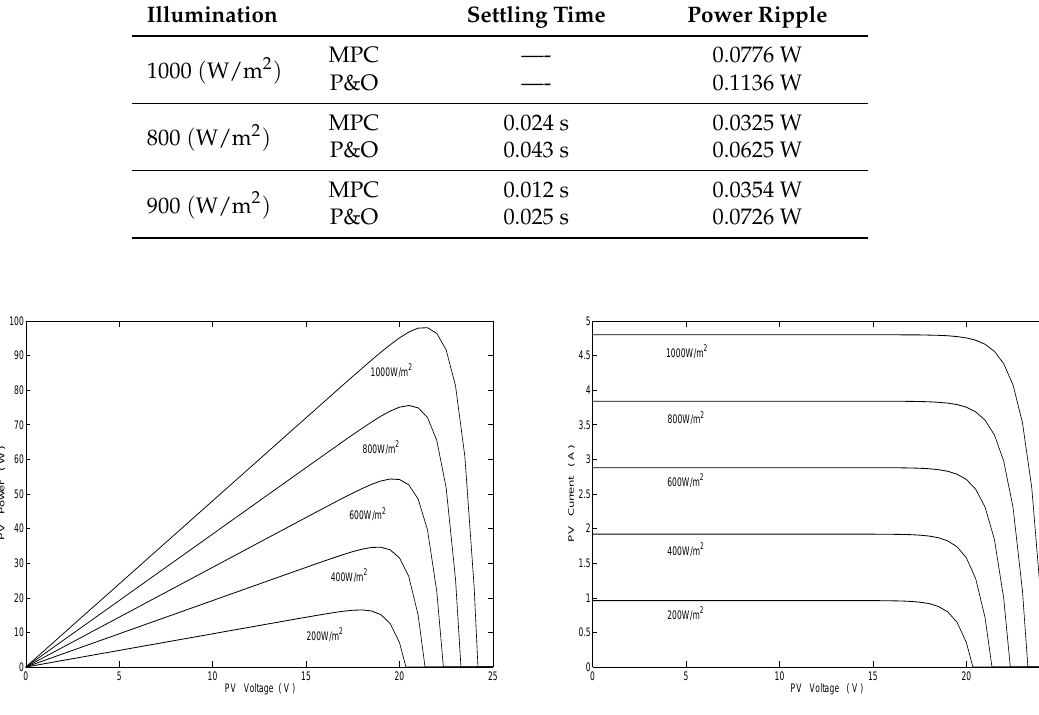
Figure 6. Characteristics of PV power and PV current with PV voltage for each PV cell under different illumination intensity.